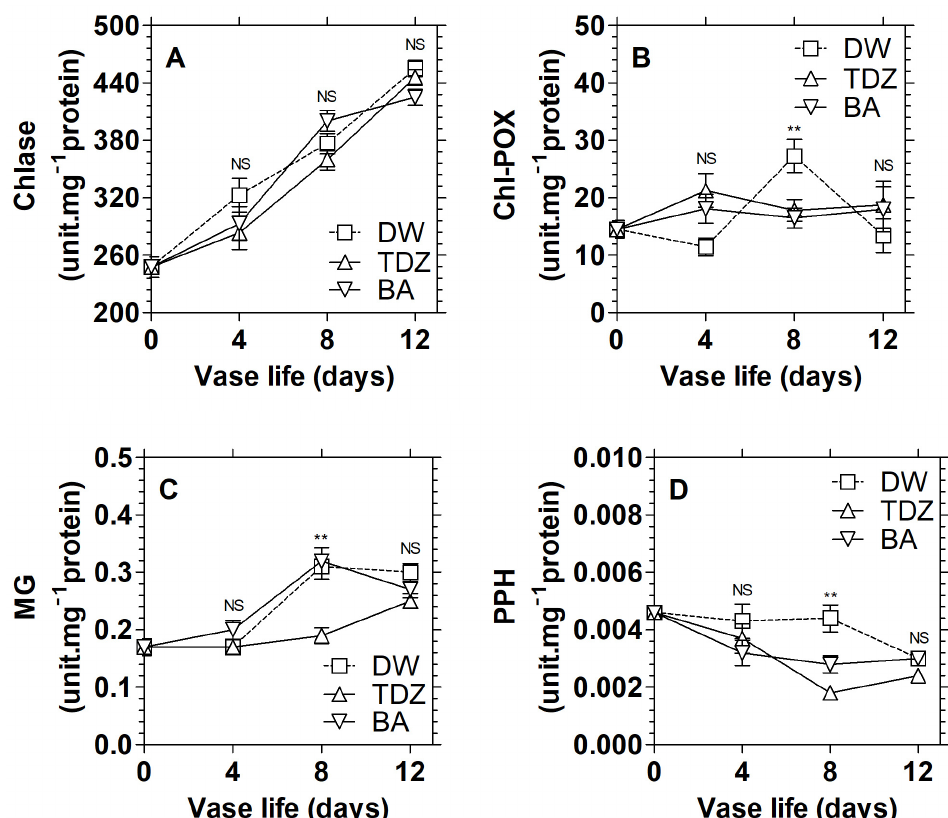
Figure 4. Effect of CKs on activities of chlorophyll catabolism enzymes; chlorophyllase; Chlase ( A ), chlorophyll peroxidase; Chl-POX ( B ), magnesium dechelatase; MG ( C ) and pheophytinese; and PPH ( D ) in D. solida leaves. Leaves were pulsed with distilled water (DW; control), 10 µ M TDZ, 100 ppm BA for 24 h, then transferred to distilled water in a controlled environment room for the vase period. Asterisks above the curves at each time point represent significant differences between treatments according to Duncan’s multiple range test (DMRT); p < 0.01 (**) and NS not significant.